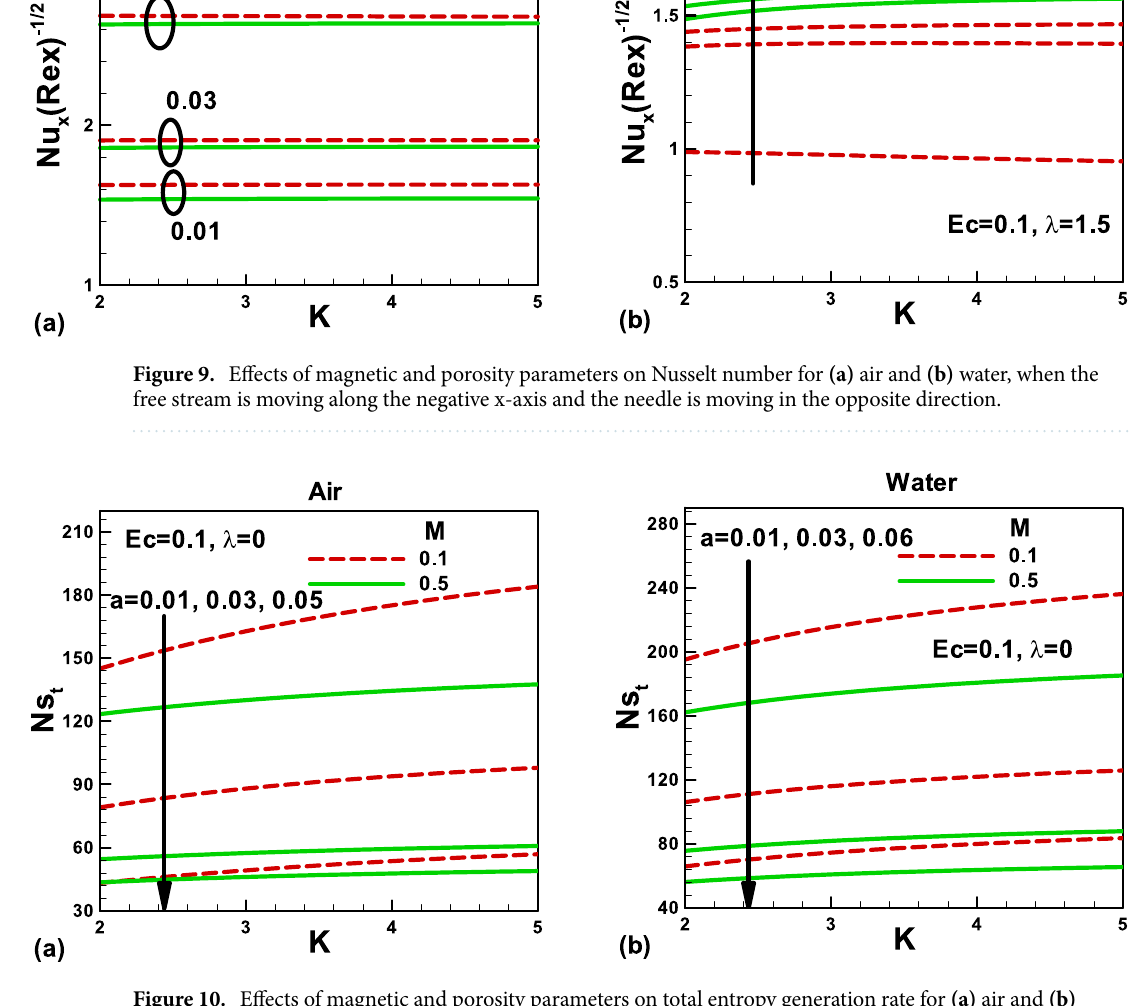
Figure 10. Effects of magnetic and porosity parameters on total entropy generation rate for (a) air and (b) water, when the needle is fixed in a moving